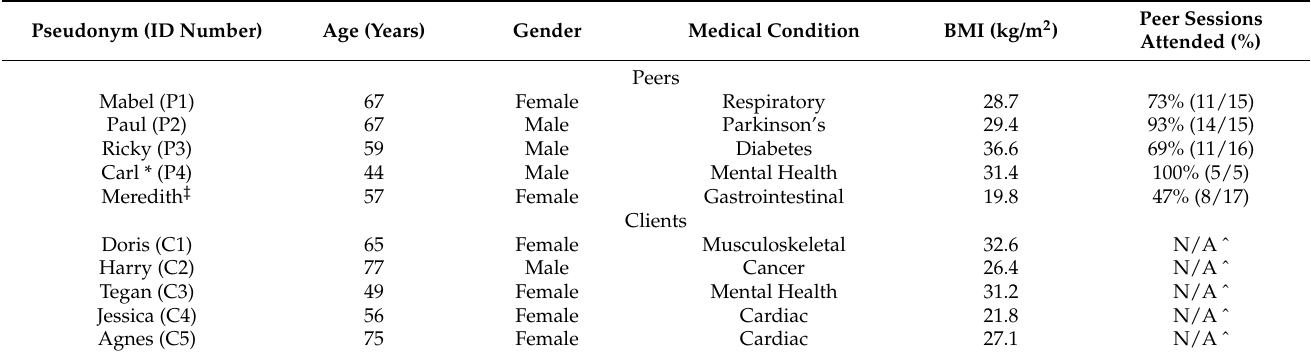
Table 1. Key demographic characteristics of peers and